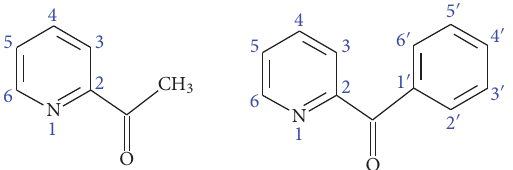
S 1: 2-acyl derivatives or pyridine: 2-acetylpyridine